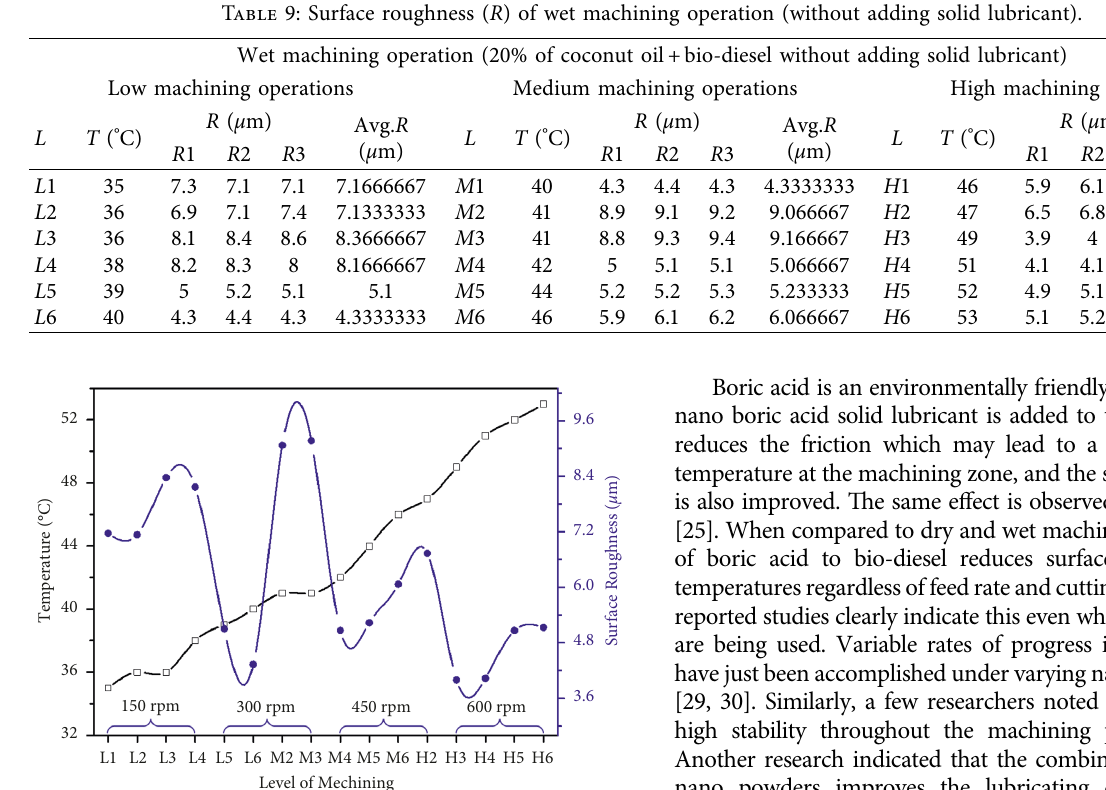
Figure 5: Surface and temperatures at different levels of cutting speed in wet